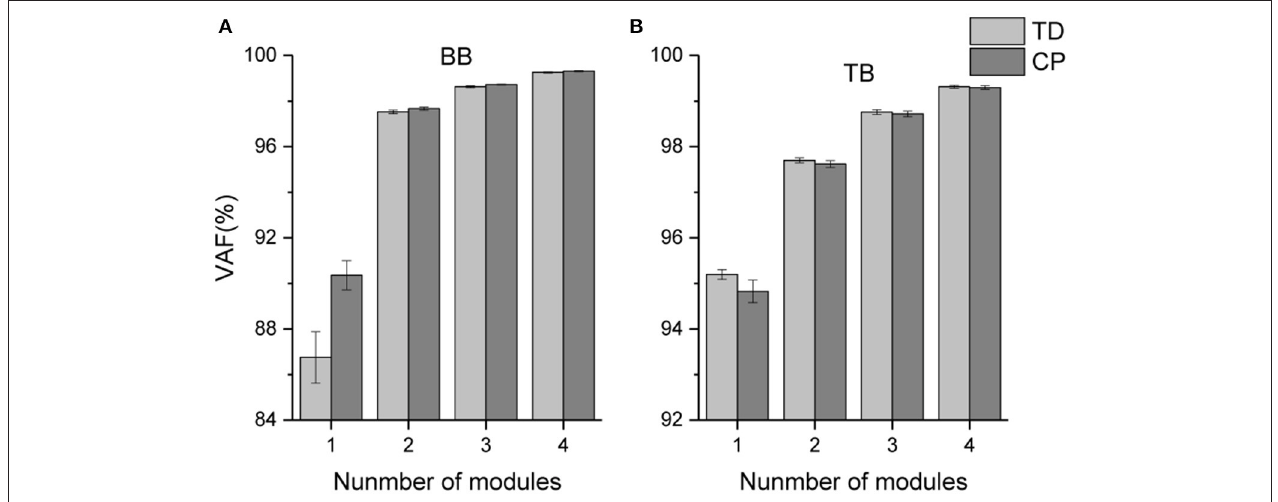
FIGURE 5 | Mean VAF values corresponding to different number of oscillation synergies.